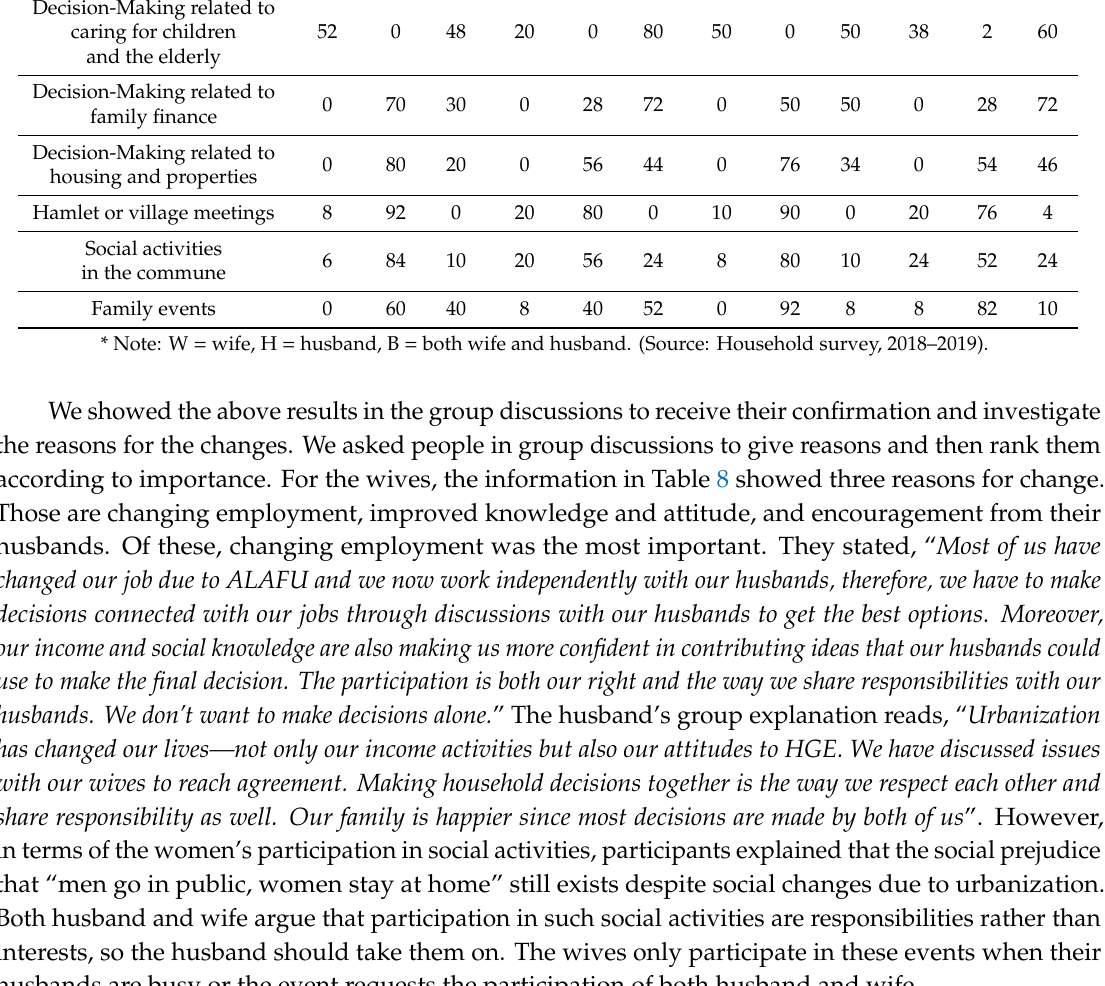
Who Have Participated